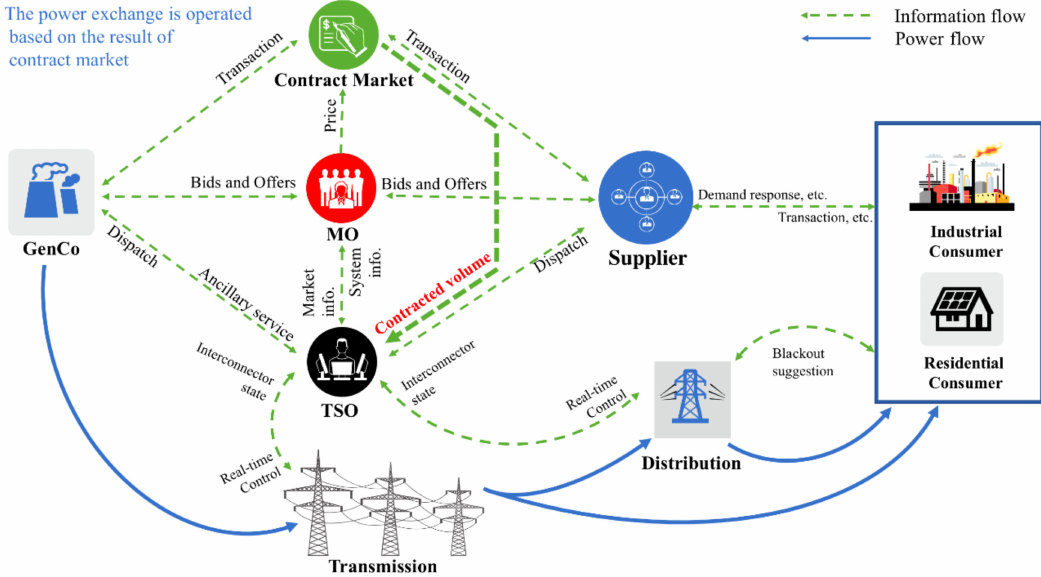
Figure 6. Framework for hybrid model.